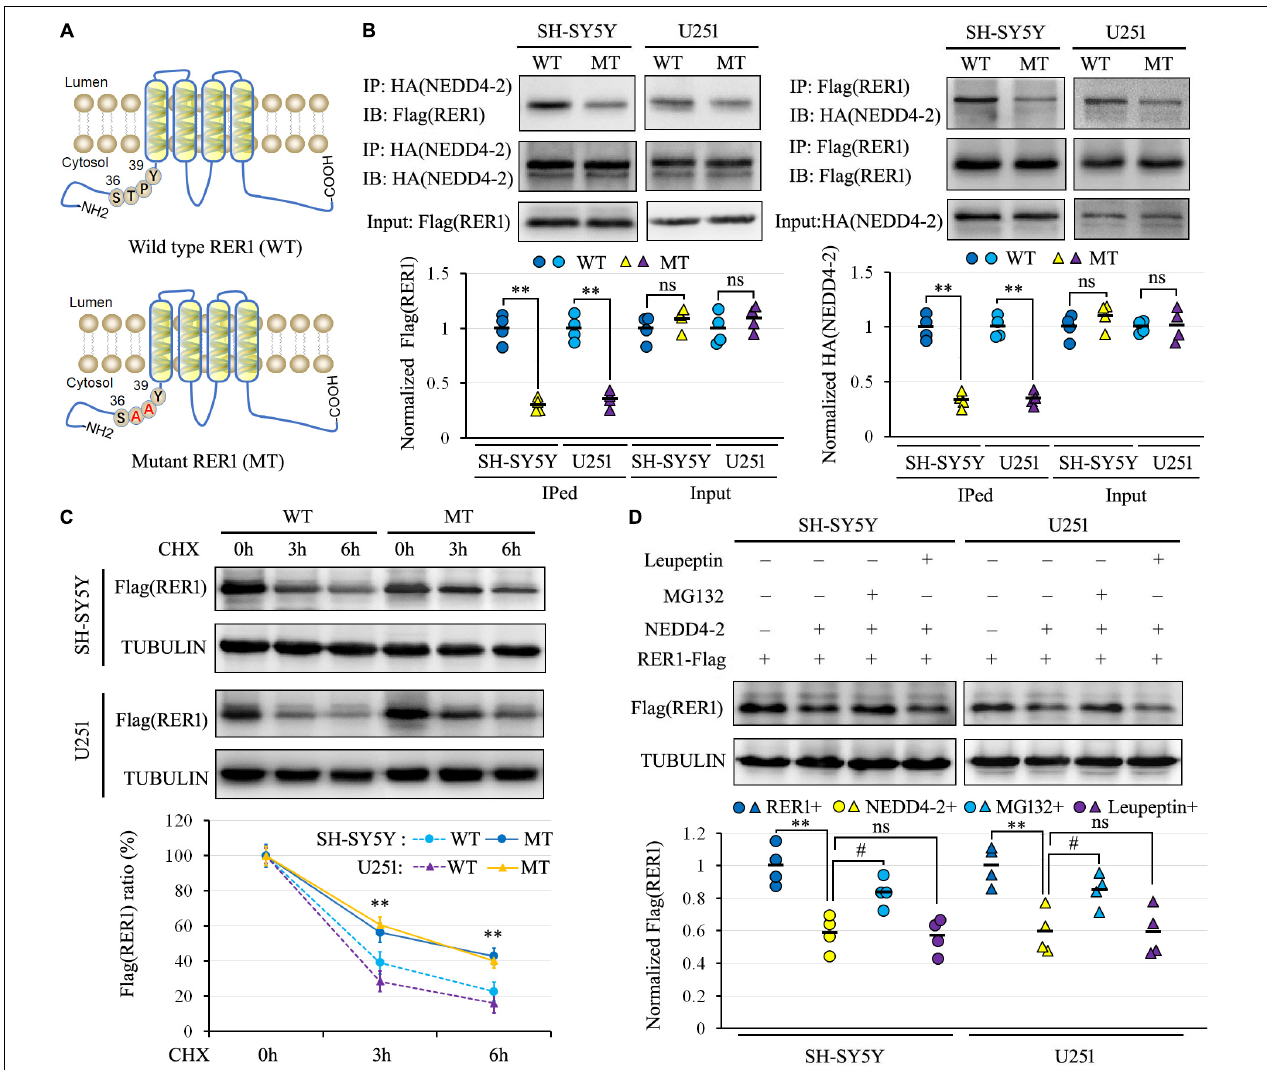
FIGURE 4 | NEDD4-2 interacted with the 36 STPY 39 motif of RER1 to elicit proteasomal degradation. (A) The schematic depiction of the wild-type (WT) and TP37_38AA mutant (MT) RER1. (B) Co-immunoprecipitation analysis for the interaction of NEDD4-2 and RER1 in co-transfected SH-SY5Y and U251 cells ( n = 4 independent cell preparations). ∗∗ P < 0.01 compared with WT control by Student’s t -test. (C) The stability analysis of RER1 in co-transfected cells with 100 µ g/mL CHX treatment by Western blotting ( n = 4 independent cell preparations). ∗∗ P < 0.01 compared with WT control by post hoc Tukey’s analysis. (D) Western